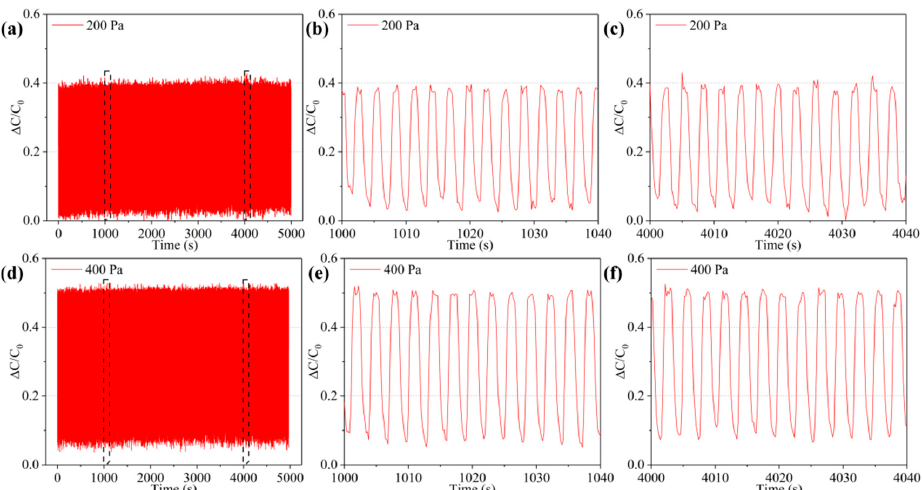
Figure 9. Repeatability test of the sensor. ( a ) Capacitance cyclic strain curve of the sensor under a pressure of 200 Pa; ( b , c ) partial graphs of Figure 6a; ( d ) capacitance cyclic strain curve of the sensor under a pressure of 400 Pa; ( e , f ) partial graphs of Figure 6d.